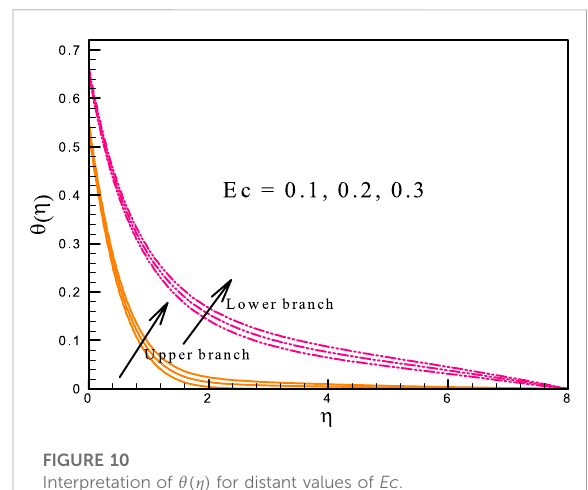
FIGURE 10 Interpretation of θ ( η ) for distant values of Ec .